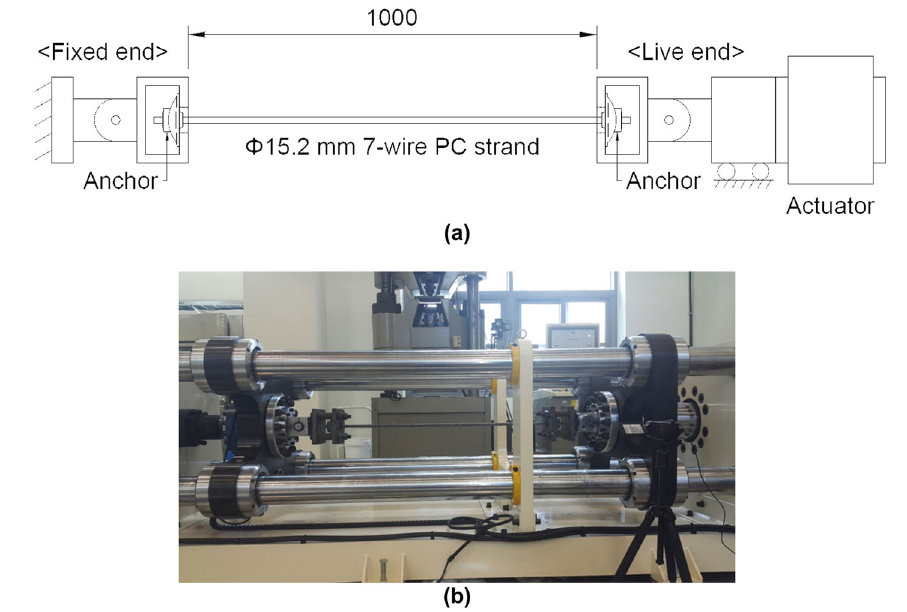
Fig. 3 Setup of fatigue test. a Section view (unit: mm) and b test